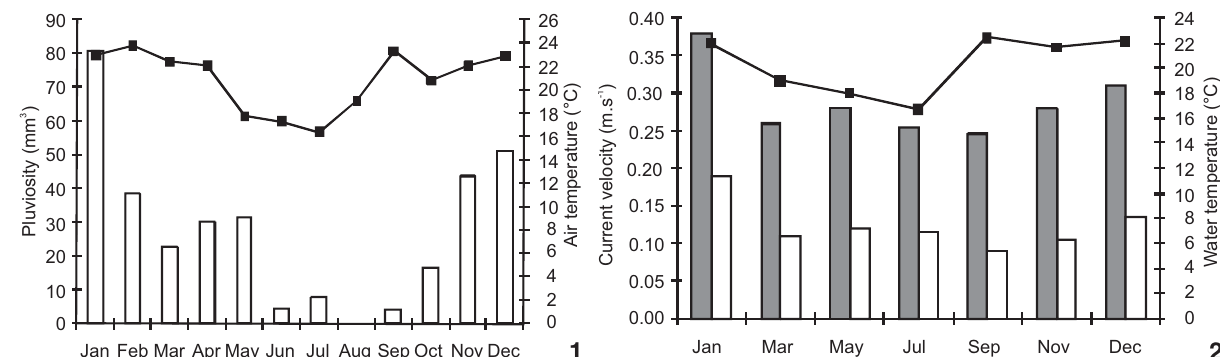
Figures 1-2. Abiotic data of the studied area measured during 2004: (1) mean values of rainfall (white bars; average of the month) and air temperature (black line; average of the month), (2) water temperature (black line; value of the sampling day) and current velocity (black bars for Deforested area and white bars for Forested area; values of the sampling day). Source of weather data: CIIAGRO (www.ciiagro.sp.gov.br), measured at a station distant 50 km from the stream.